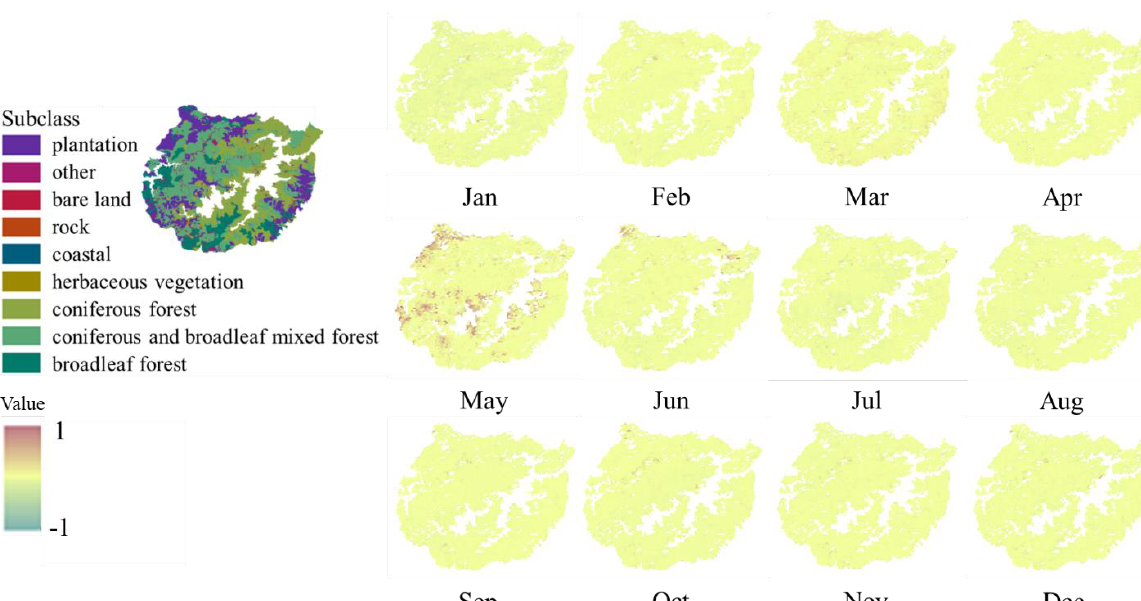
Figure 7 The differences between the predicted and observed NDVI in 2016